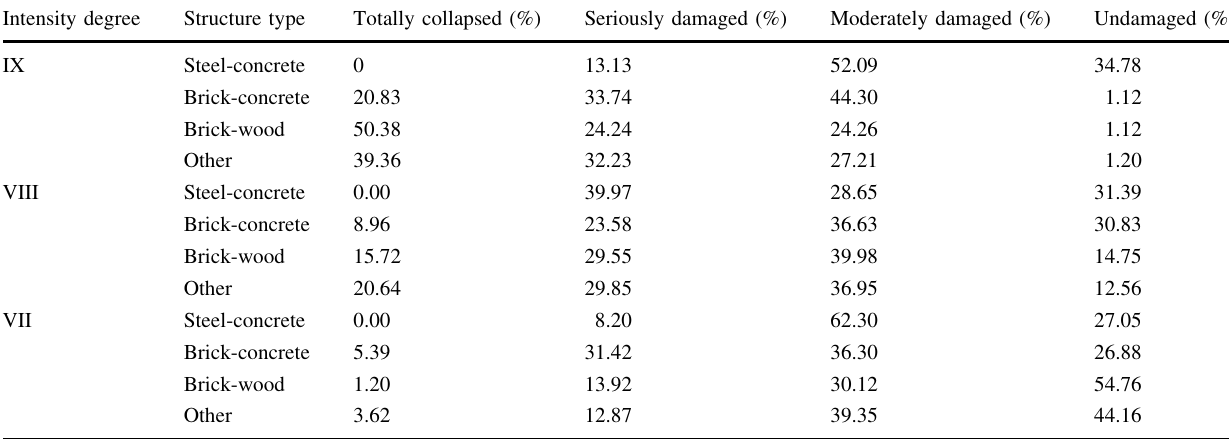
Fig. 7 Assessment result of building damage caused by the 2014 Ludian Earthquake in Yunnan Province, using UAV remote sensing Table 5 Building damage proportion matrix from remote sensing analysis of selected typical areas within the VII-degree seismic intensity line of the 2014 Ludian Earthquake, Yunnan Province, China Intensity degree Structure type Totally collapsed (%) Seriously damaged (%) Moderately damaged (%) Undamaged (%)